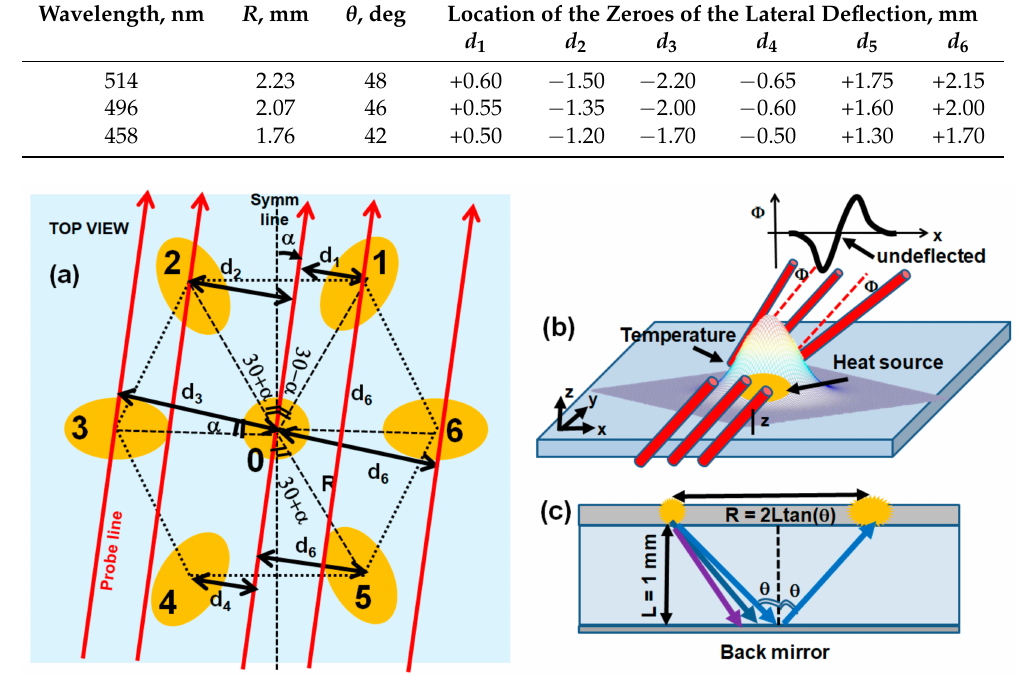
Figure 4. Scheme of the photothermal deflection measurements of the diffracted orders. ( a ) Top view. Example of zeroes of the lateral deflection signal when the probe beam is passing above the center of the heat source produced by the diffracted orders; ( b ) typical antisymmetric behavior of the lateral beam deflection; ( c ) lateral view. Propagation of one diffracted order and the formation of the surface heat